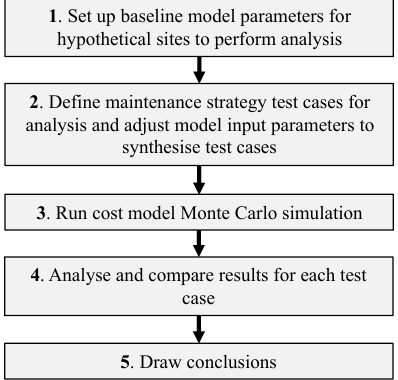
Figure 1. Overall approach to